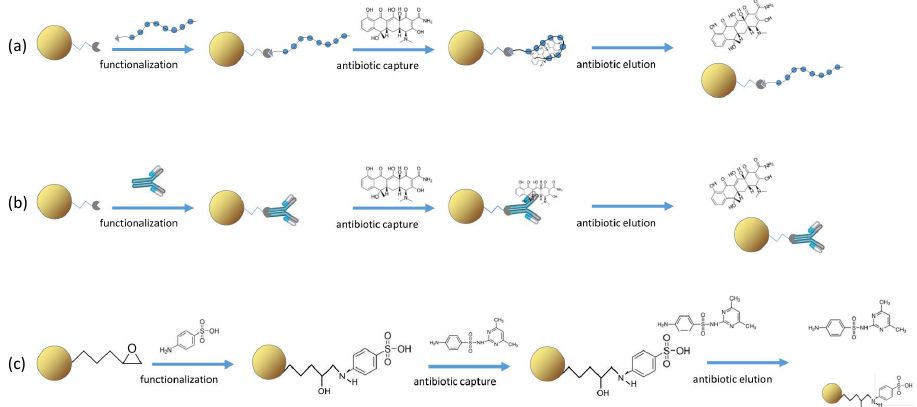
Figure 2. Strategies for the purification of antibiotics. Beads exposing specific functional groups are covalently coupled to the recognition element (functionalization), which binds its antibiotic target (antibiotic capture). Molecules present in the matrix are washed away, while the antibiotic is retained. By changing the environmental conditions (pH, ionic strength, temperature), the antibiotic is released (antibiotic elution) and collected for further analyses. ( a ) Strategy based on beads functionalized with aptamers as recognition element; ( b ) strategy based on beads functionalized with antibodies as recognition element; ( c ) strategy based on beads functionalized with sulfone groups for the purification of